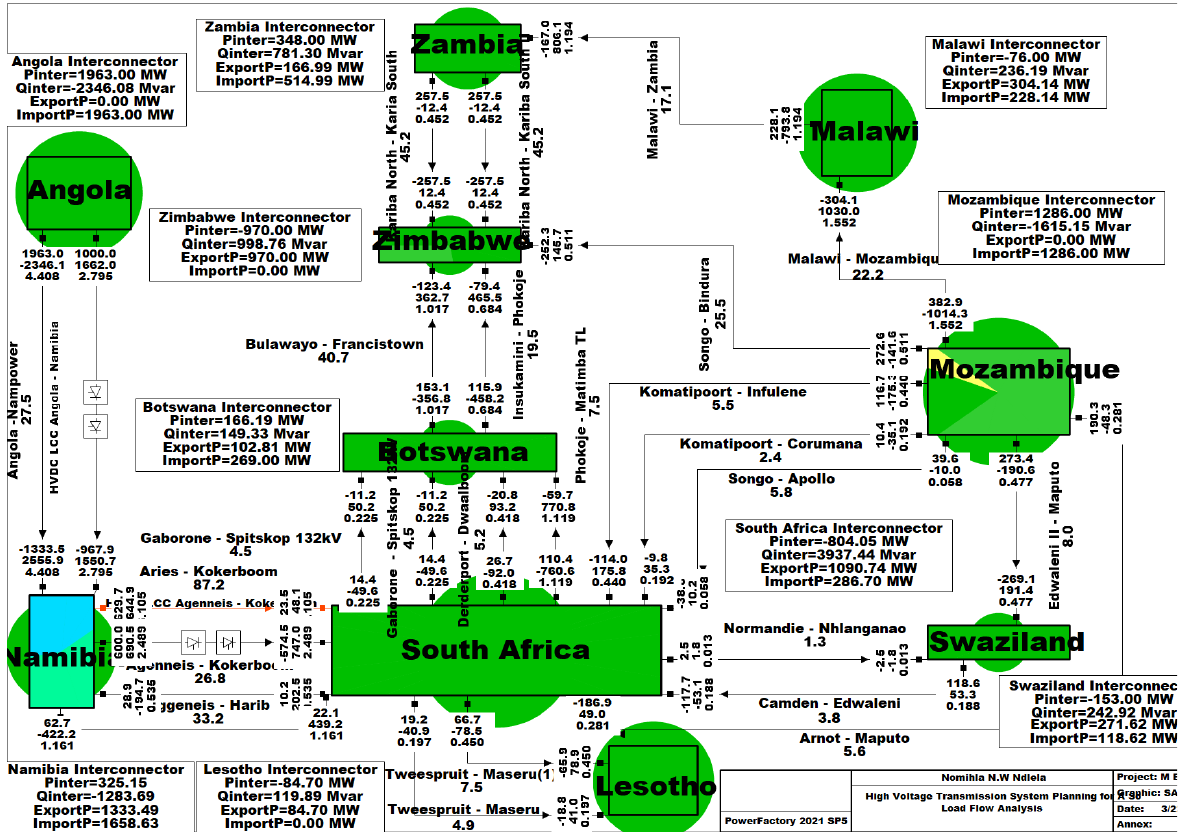
Figure 9. Southern African Region with HVdc LCC link.